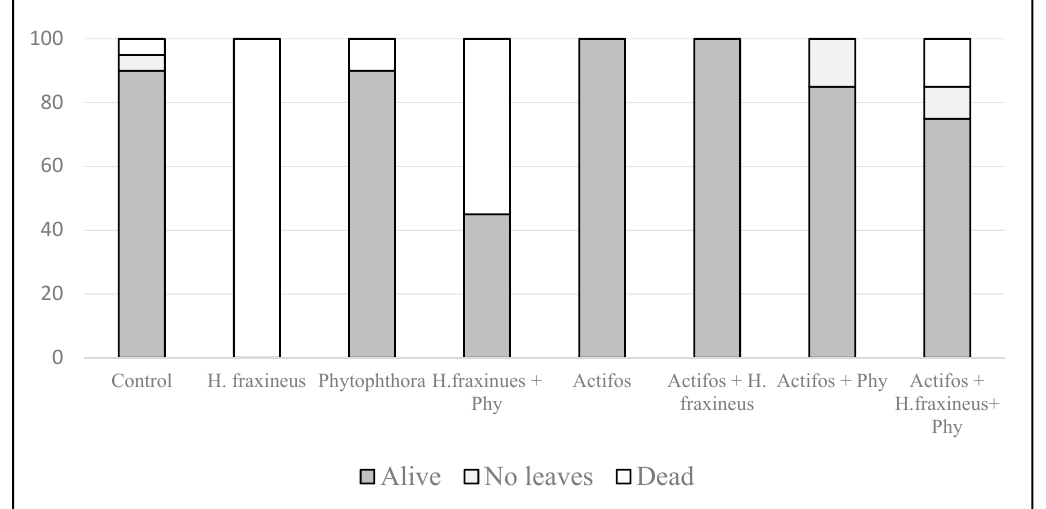
Figure 2. Survival of ash seedlings vs. mortality rate at the end of experiment (September 2017).